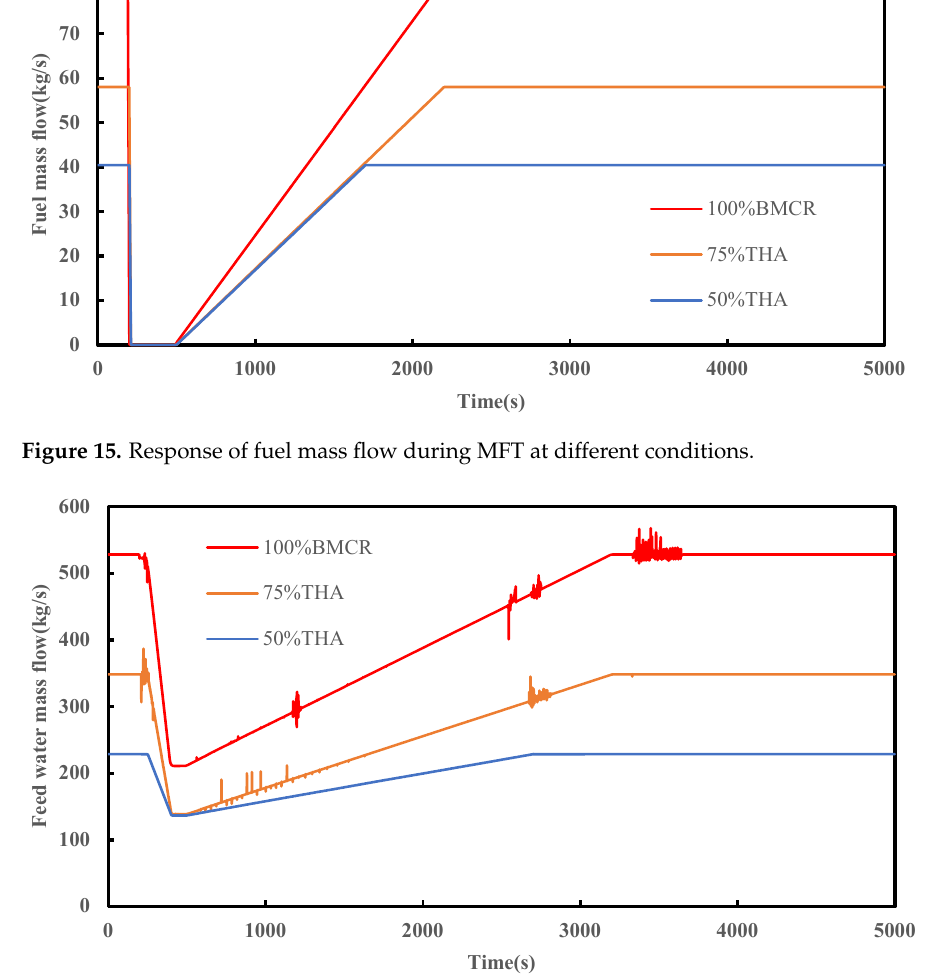
Figure 16. Response of feed water mass flow during MFT at different conditions.